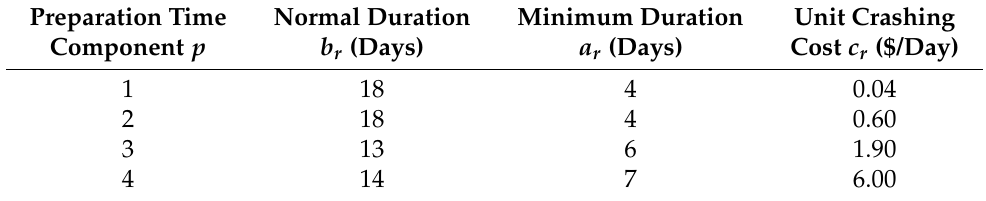
Table 4. Preparation times of different